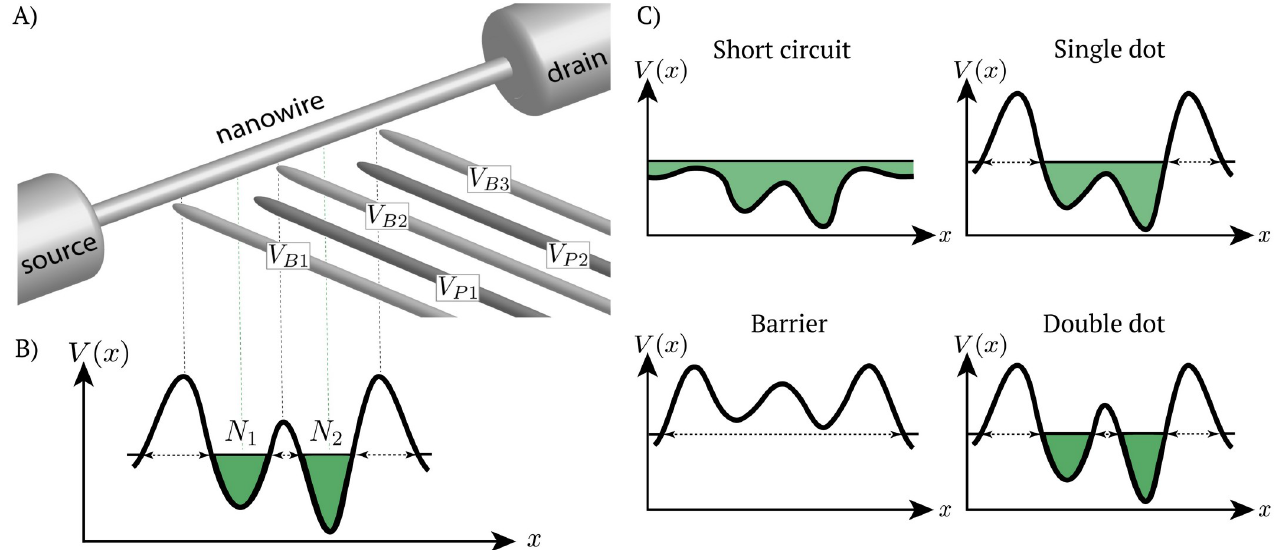
Fig 1. Quantum dots from a nanowire. A) A generic model of a nanowire with 5 gates. The barrier gates, V Bi with i = 1, 2, 3 (light gray), are set to a fixed voltage and are used to form islands by confining electron density to certain region. Voltage on the plunger gates, V Pj with j = 1, 2 (dark gray), is varied to allow for control of the current flow through the nanowire. B) Potential profile along a nanowire for a double dot system with N 1 and N 2 denoting the number of electrons on each dot. C) Possible states in the 5-gate device. In the short circuit state the potential profile is below the Fermi level, leading to an unintended current flow. When the potential profile is above the Fermi level, the current flow is blocked (barrier state). By varying the voltage applied to plunger gates in the lower range while keeping the barriers above the Fermi level of the contacts, one can transition between one and two dots.